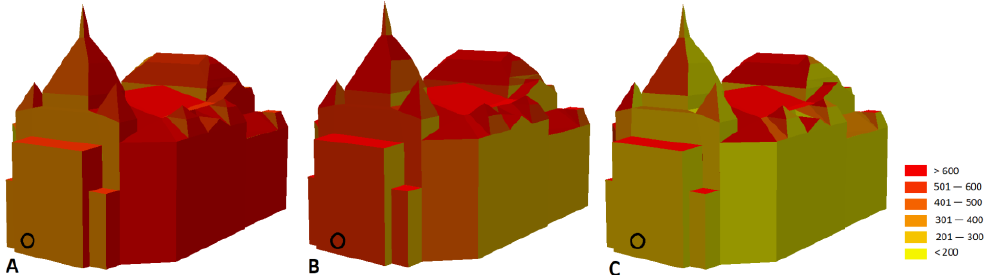
Table 3. Solar irradiance at the State Theatre in W/m 2 on 23 June 2021.